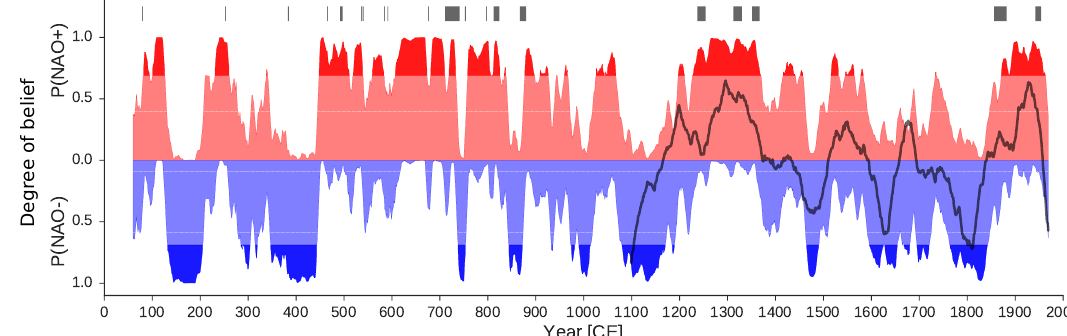
Figure 6. Degree of belief (probability) that the NAO is in a specific (positive vs. negative) phase during each 50-year time window. The figure has been smoothed by a 10-year moving-average filter to enhance its readability. The brighter areas indicate time intervals for which less than 66% of all considered MCMC ensemble members agree upon the sign of the reconstructed NAO variable. Gray bars correspond to known major drought episodes in the western Mediterranean as discussed in Sect. 5. For better comparison, the NAO reconstruction by Ortega et al. (2015) is shown as a black line, indicating a general agreement with our probabilistic reconstruction over the common period as